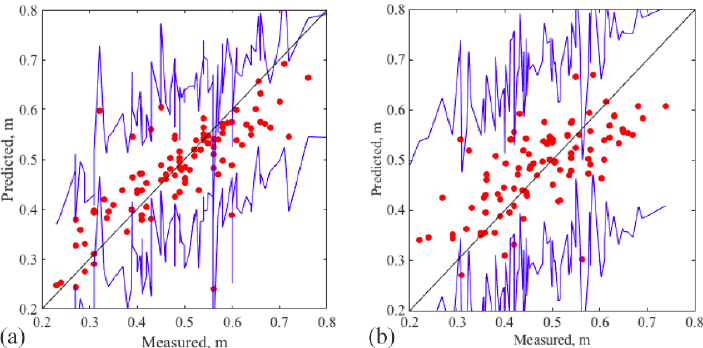
Figure 9. Estimated mean and confidence intervals from the Bayesian method, compared to the probe-measured snow depth by (a) using the correlation to microtopography and (b) interpolating the snow surface. The red circles represent the snow depth at the validation locations (the snow depth probe measurements not used in the estimation), the blue lines are the confidence intervals based on the standard deviation (SD) multiplied by 1.9 (94% confidence intervals), and the black lines are the one-to-one